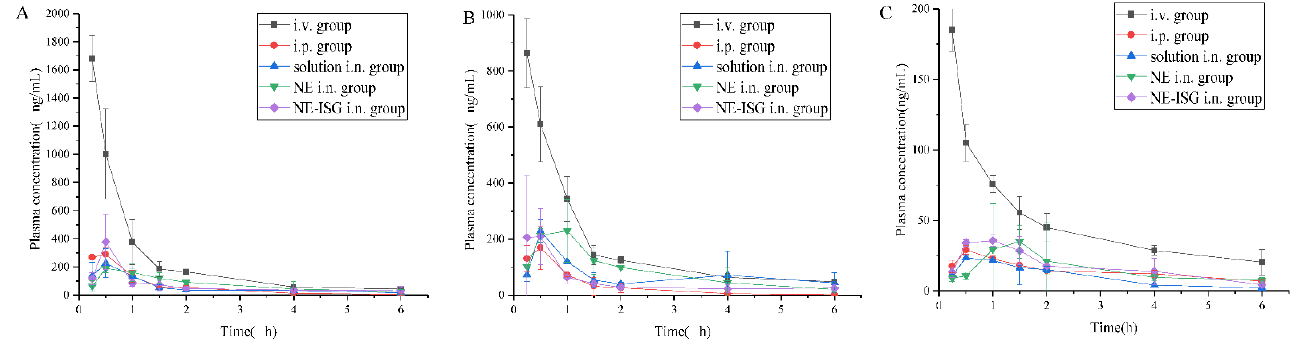
Figure 5. Concentrations of components plasma samples of each group after administration of Chaxiong volatile oil preparation ( n = 3, ⎯ X ± SD). ( A ) Senkyunolide A. ( B ) Neocnidolide. ( C ) N-Butylphthalide.